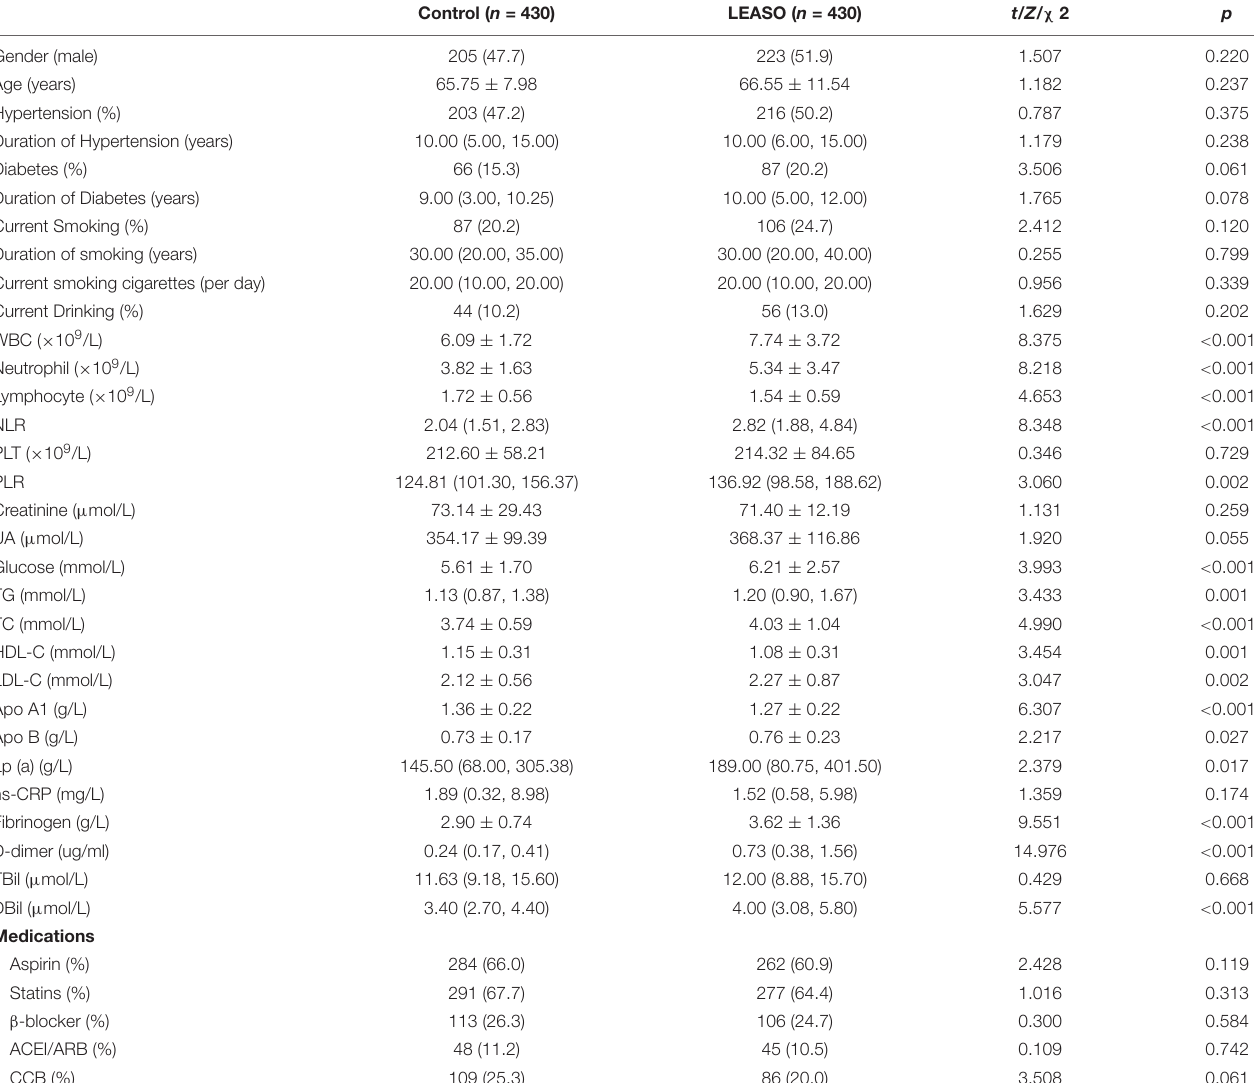
TABLE 1 | Characteristics of LEASO group and control group.